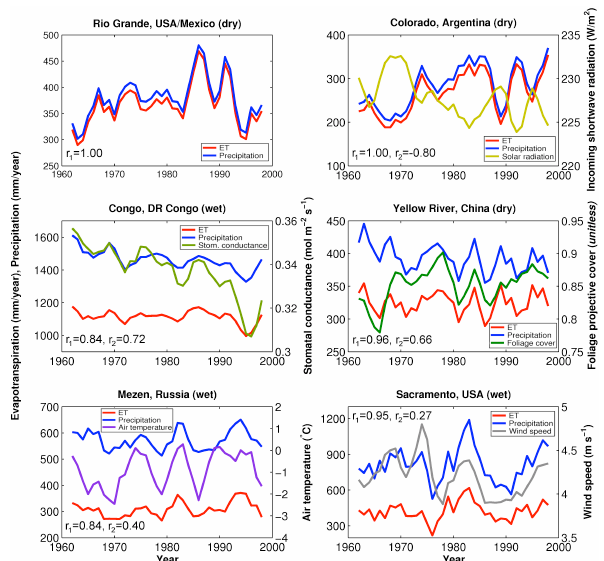
Fig. 4. Examples of interannual variability in water balance ET and its relationship with precipitation, solar radiation, stomatal conductance, foliage cover, air temperature and wind speed. Three-year block averages were used to smooth time series. Correlation coefficients for ET against precipitation ( r 1 ) and the second plot variable ( r 2 ) are shown. The location of each basin is indicated in Fig. 1.